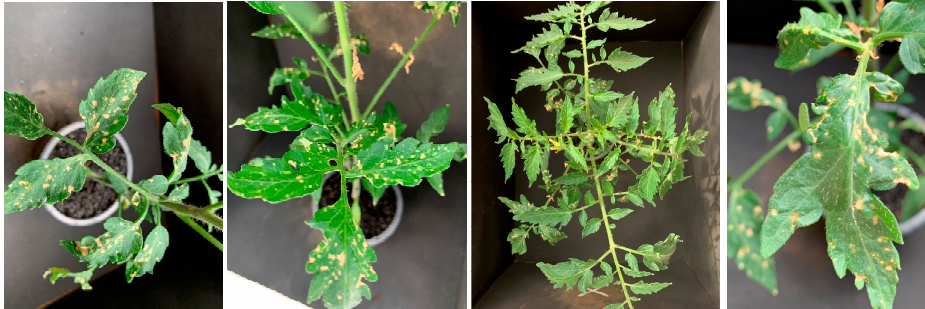
Figure 7. Symptoms evolution in tomato plants due to simulated sa fl ufenacil drift at dose ratios 1/16D, 1/32D, and 1/64D (8.75, 4.38, and 2.19 g a.i. ha − 1 , respectively) of the recommended dose (D). Evaluations were made from 1 to 7, 14, and 21 days after application (DAA). Front view ( A ) and top view ( B ) of tomato plants a ff ected by simulated drif.